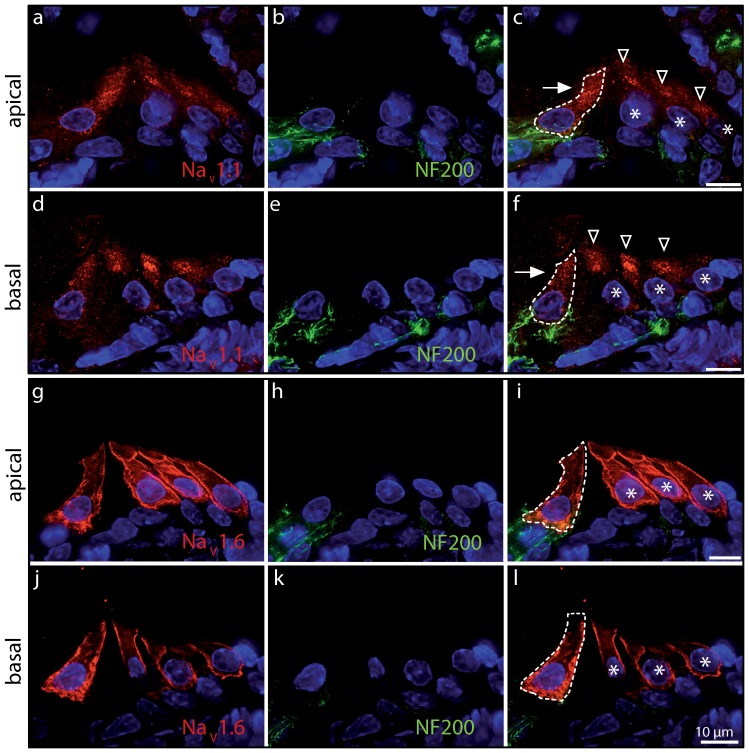
NaV 1.1 and NaV 1.6 are expressed in immature cochlear hair cells.Apical (a–c, g–i) and basal (d–f, j–l) cochlear turns of immature rat (P5) immunolabeled with antibodies against NaV 1.1 (a, d; red) and NaV 1.6 (g, j; red). Note that both IHCs and outer hair cells (OHCs) are labeled. Anti-NaV 1.1 antibody labeling was mainly found in the supranuclear region of IHCs (arrow) and OHCs (arrowheads) and less intensely present in the cell membrane, which could reflect a high rate of channel turnover. Labelling was absent in adult IHCs (P20: data not shown), which do not have a Na+ current. Labeling for NaV 1.6 was more obviously located to the membrane in both cell types. Co-labeling with anti-neurofilament antibody (NF200, green) showed no expression of NaV 1.1 or NaV 1.6 in afferent nerve fibres. Scale bars represent 10 µm. Cell nuclei are marked by DAPI (blue).